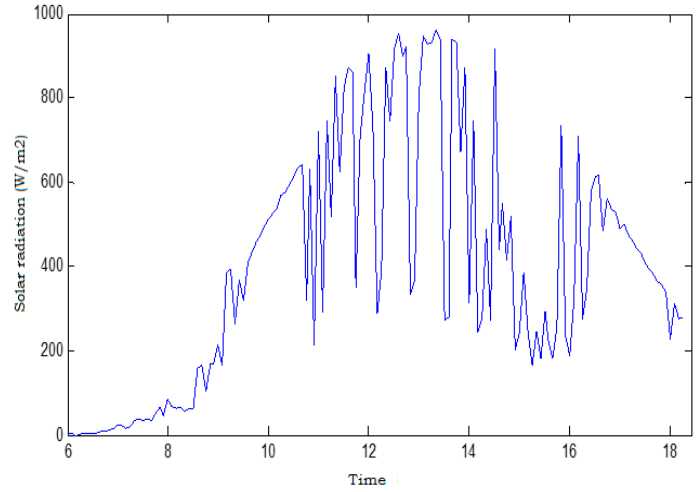
Figure 8. Evolution of solar radiation in W/m 2 for a summer day.